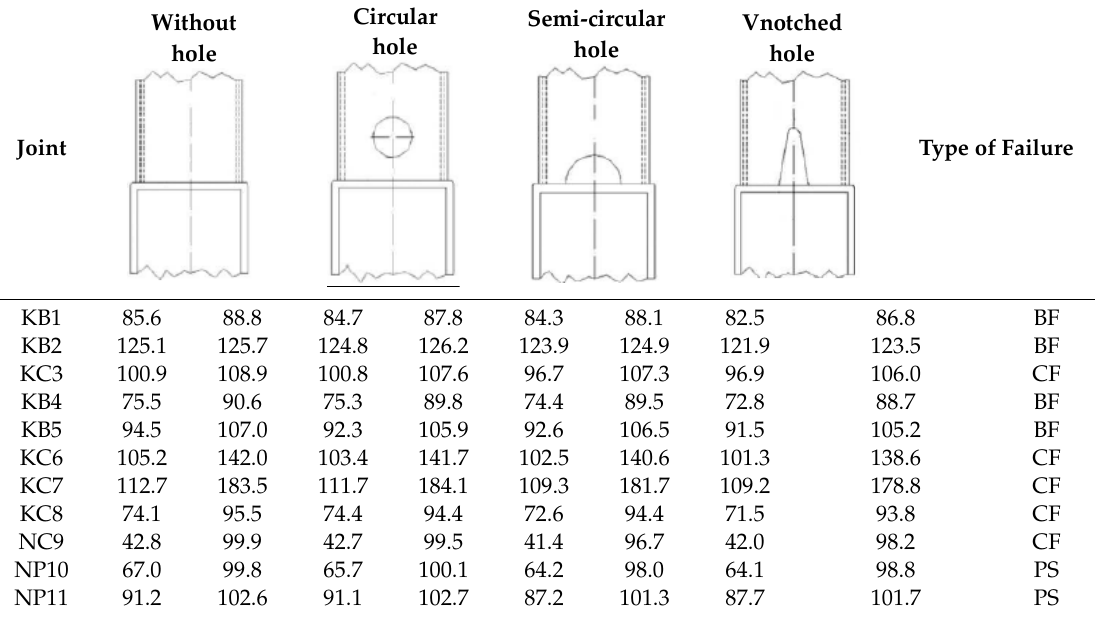
Joint Joint Joint